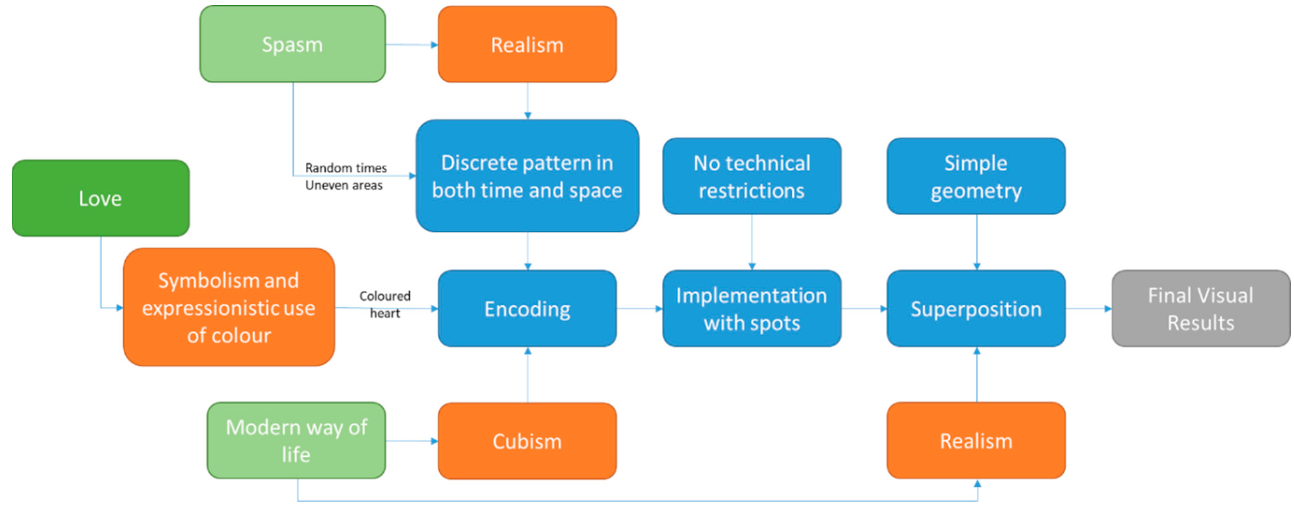
Figure 7. Working Diagram I depicts the concept of “love” with lighting.